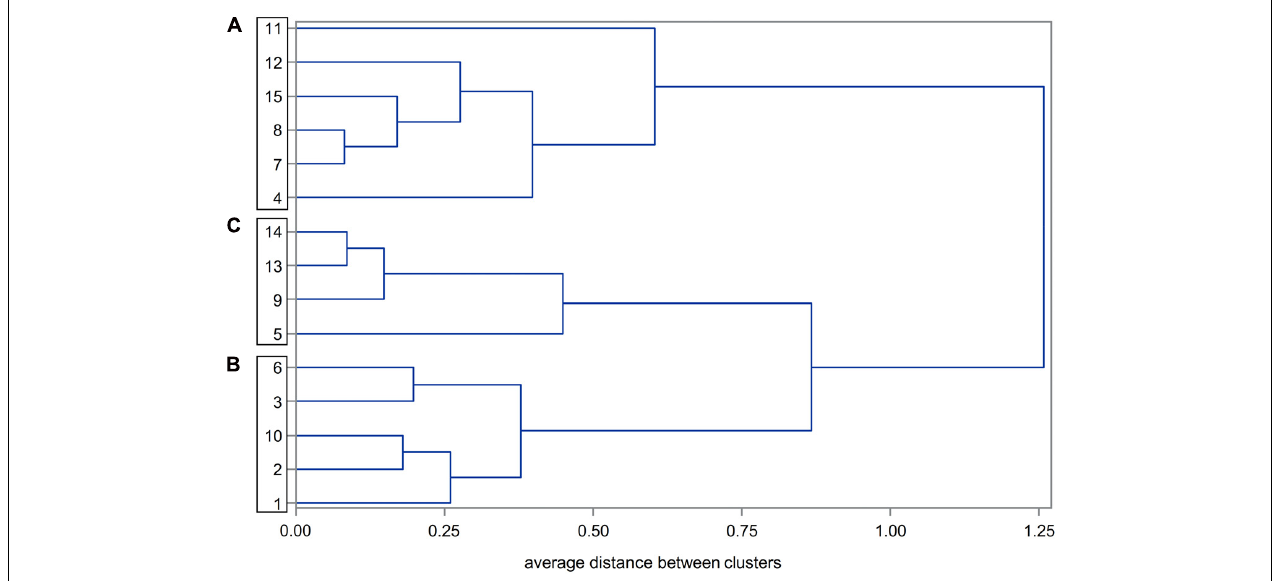
FIGURE 5 | Dendrogram of sugar beet varieties obtained through average linkage cluster analysis based on disease severity of Cercospora leaf spot and relative loss of white sugar yield (WSY). 15 varieties tested at 15 environments in Germany, 2014–2016 under high infection in the non-treated level. Relative loss in WSY is the yield difference between healthy and non-treated fungicide levels as percentage of WSY in the healthy level. (A–C) Denote clusters with an average distance of 0.7.